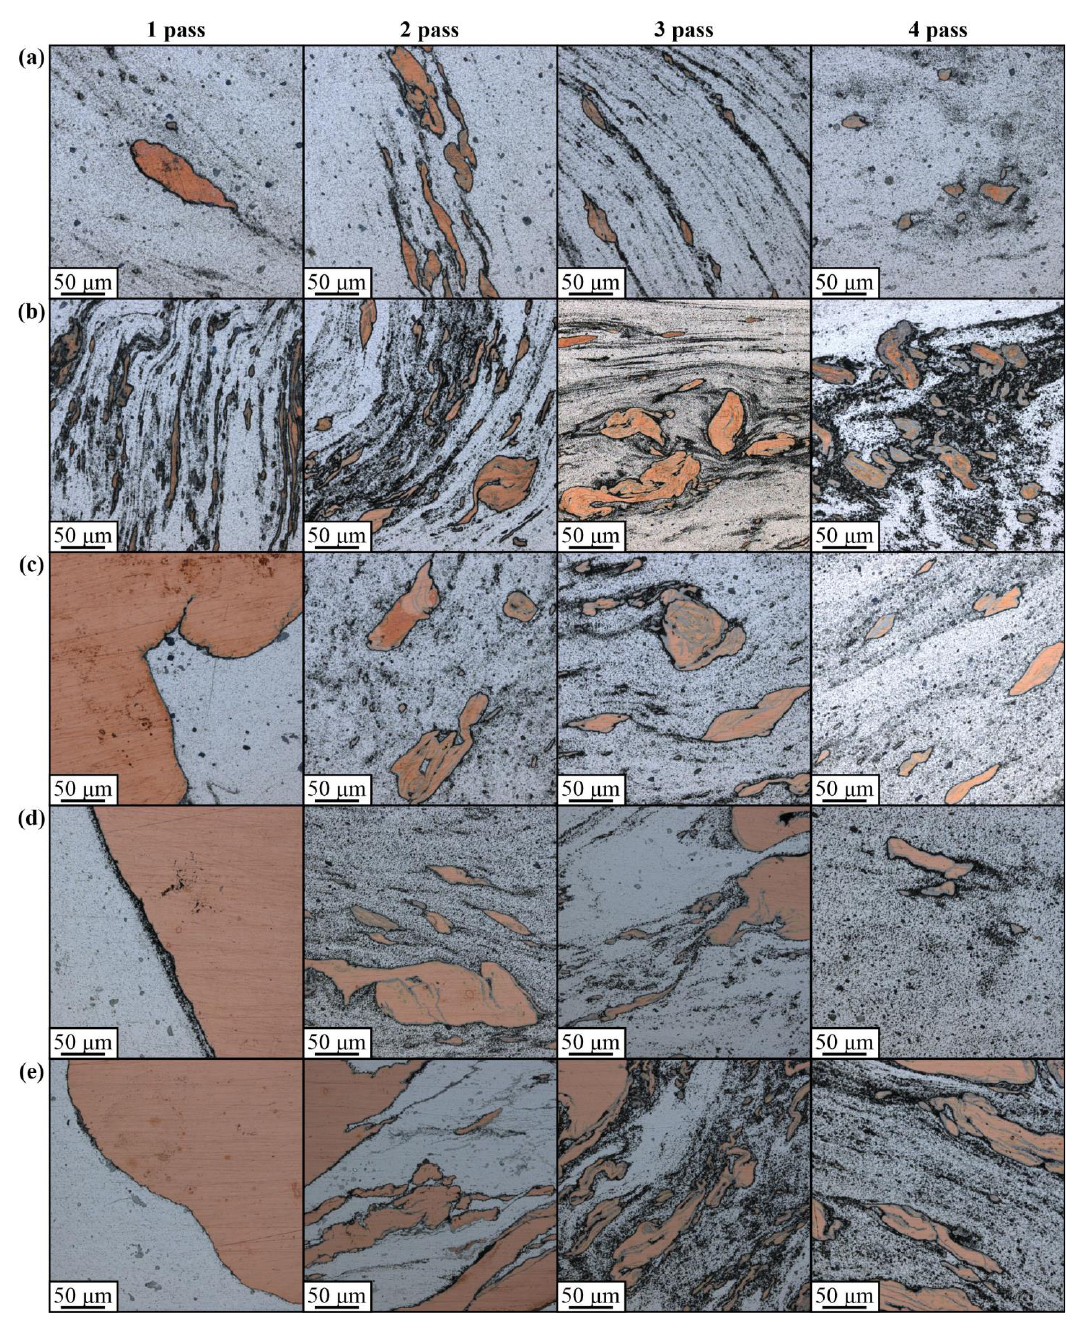
Figure 4. The stir zone macrostructure evolution with the FSP pass number from 1 to 4 views in samples containing 1.5% ( a ), 3% ( b ), 6% ( c ), 15% ( d ) and 30% ( e ) copper.